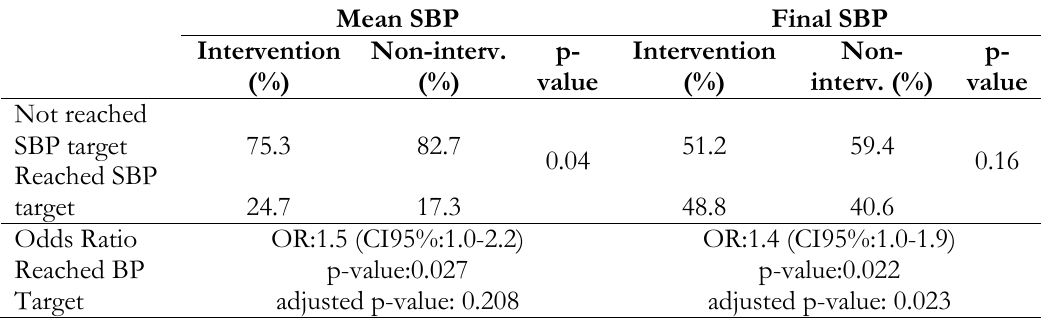
Table IV. Proportion of mean sbp and final follow-up sbp compared to sbp target in intervention vs. non-intervention